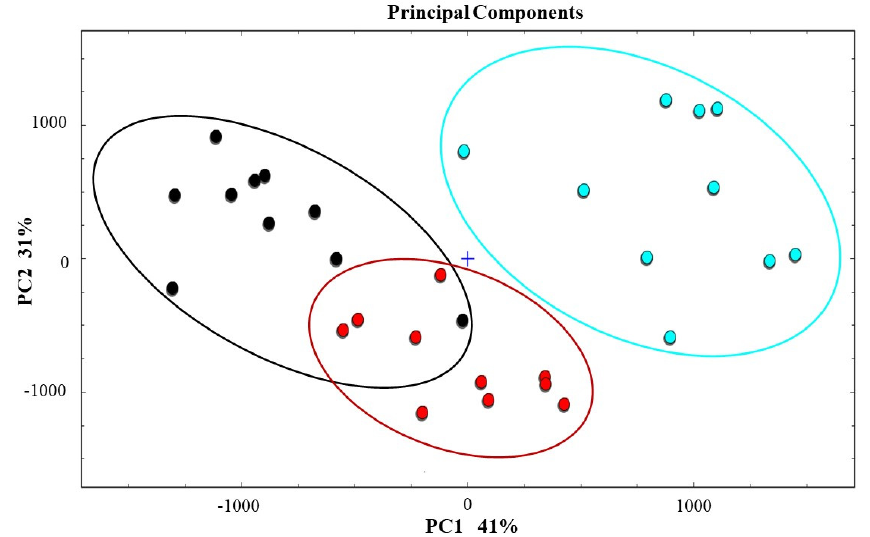
Figure 3. In the PCA diagram, the black points are the HR group samples (HR1 ‐ HR10), the blue points are the MR samples (MR1 ‐ MR10), and the red points are the LR samples (LR1 ‐ LR10).